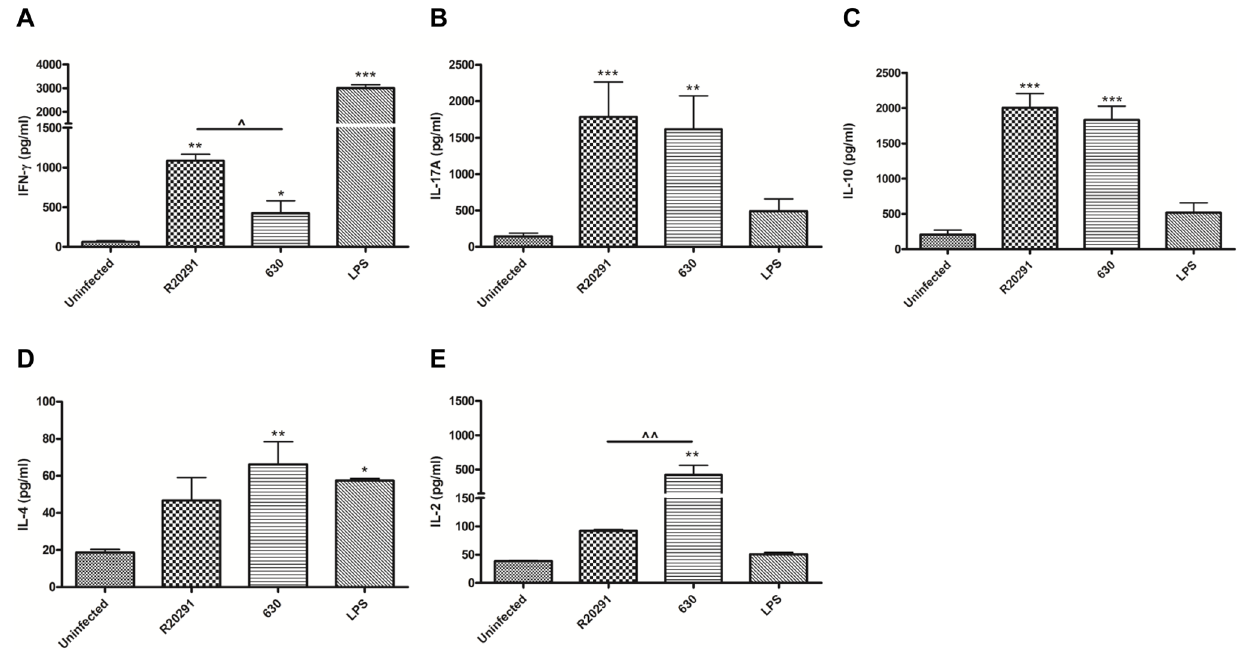
Figure 7. Generation of Th1/Th17 mediated immunity in response to C.difficile in an in-vitro murine model system. WT BMDCs were infected with PFA-fixed C. difficile strains. 24 h post-infection, stimulated BMDCs were co-cultured with WT splenocytes in the presence of anti-CD3/ CD28. 96 h post co-culture, secreted cytokines IFN- c (A), IL-17A (B), IL-10 (C), IL-4 (D) and IL-2 (E) were measured by ELISA. 1 m g/ml LPS stimulation served as reference control. Data represent mean 6 SEM, n=3. */ ‘ p , 0.05, **/ ‘‘ p , 0.01 and ***p , 0.001 represent significant difference when compared to uninfected control cells and significant inter-strain difference, respectively. P values were obtained using ANOVA with Bonferroni post- test